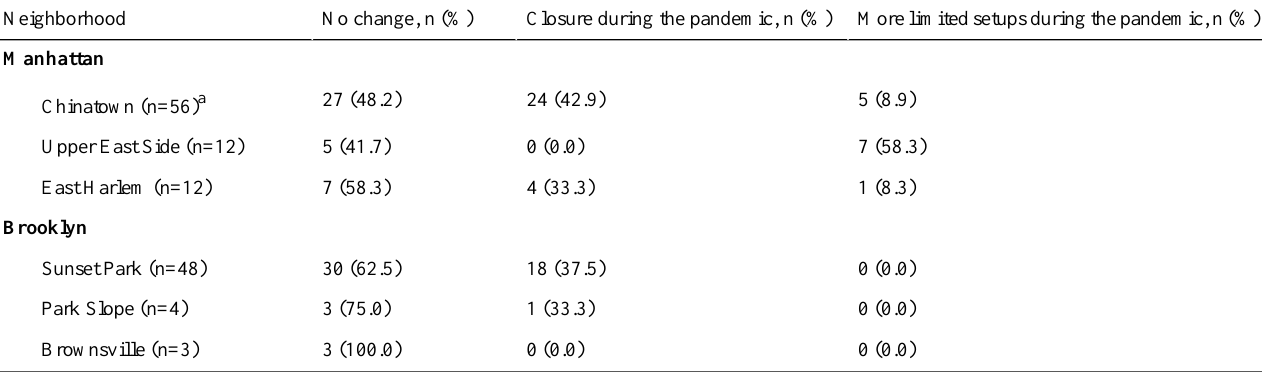
Table 3. Preliminary findings on closures of fresh fruit and vegetable vendors in select New York City neighborhoods during the COVID-19 pandemic using Google Street View